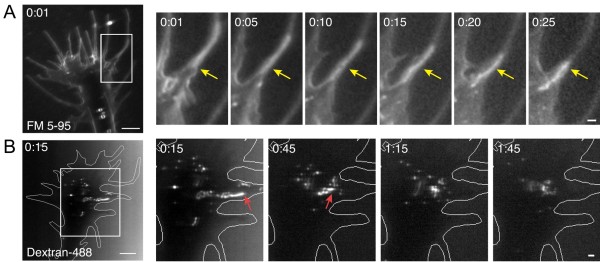
Endocytosis of elongated tubules in the growth cone periphery. (A) Time-lapse confocal images of FM 5-95 internalization show immediate dye incorporation into an elongated tubule (yellow static arrow) near the base of a filopodium. In subsequent frames, the endocytic tubule is transported retrogradely toward the growth cone central domain. The boxed area is magnified in the panels at the right and the time after the initial membrane labeling (minutes:seconds) is indicated in each frame. See Additional file 8. (B) Time-lapse confocal images of fluorescent dextran internalization show similar endocytosis of an elongated tubule (red arrows) near the base of a filopodium. The focal pulse (10 s) of fluorescent dextran was applied at 0:00 and the initial frame shows nascent endocytic vesicles immediately after the removal of uninternalized dextran (0:15). Endocytic vesicles originating in the peripheral domain move retrogradely and fuse with other dextran-containing vesicles near the transitional- or central domains of the growth cone within one minute. See Additional file 12. Scale bars, 5 μm (left), 1 μm (right).